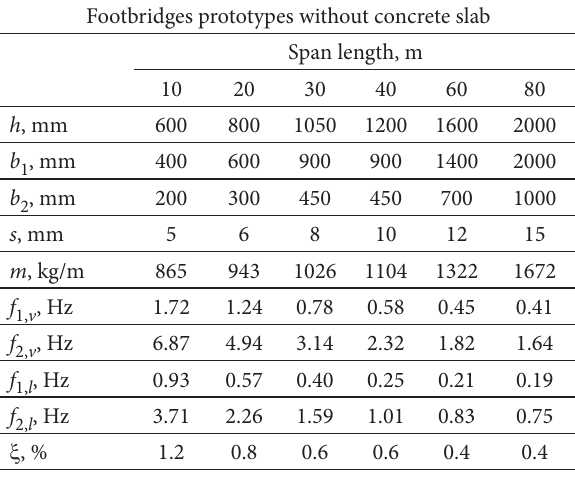
Table 2. Geometric and dynamic properties of the prototype